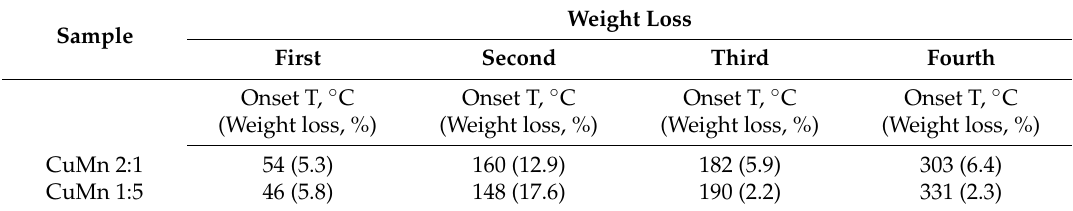
Table 2. The thermogravimetric data for alumina-supported Cu-Mn (2:1 and